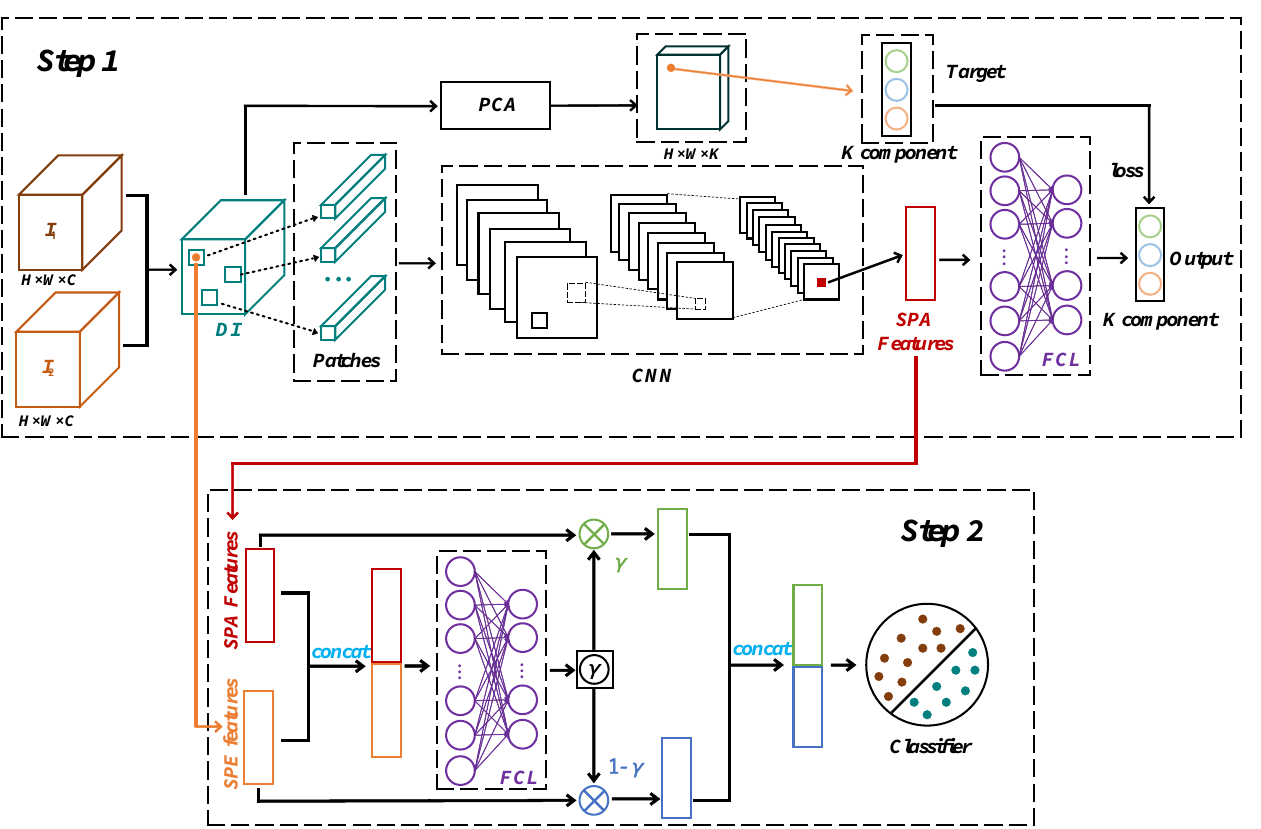
Figure 1. Framework of the proposed ASSCDN. The first step is PCA-guided self-supervised spatial feature extraction network. The second step is to combine the spectral and spatial features by introducing a attention mechanism and obtain the final